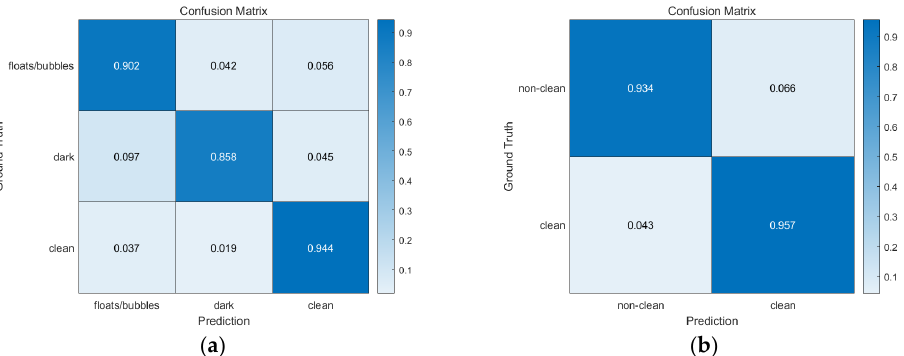
Figure 4. Pixel-level confusion matrix of our semantic segmentation algorithm based on DeepLab v3. ( a ) 3-class. Clean region exhibited better accuracy compared to other regions. ( b ) 2-class. Both clean and non-clean regions were fairly well classified correctly.